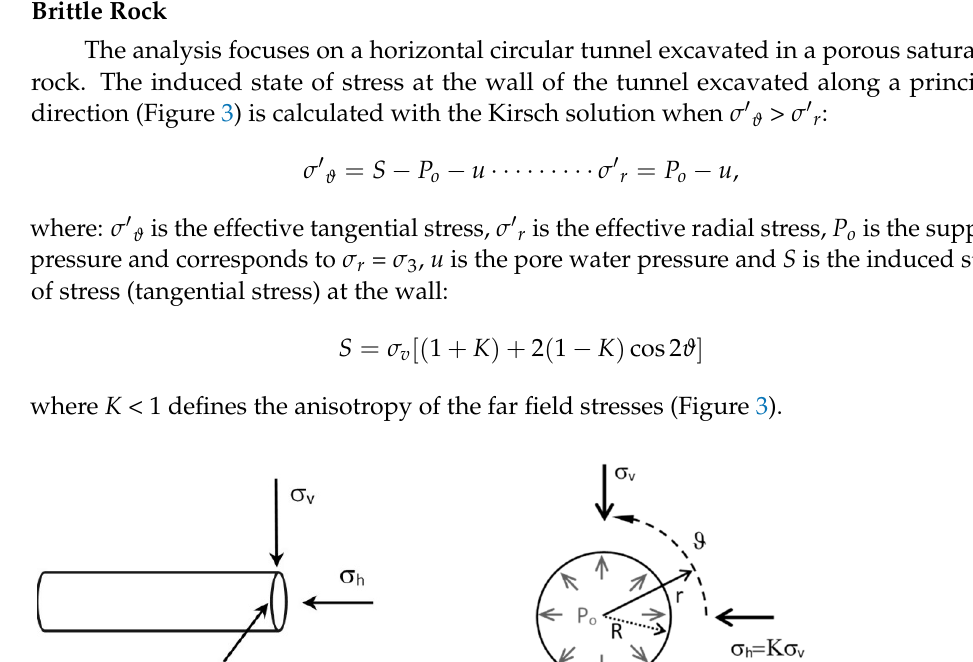
6 of 17 Table 1. Parameters obtained by data fitting of Vosges sandstone.